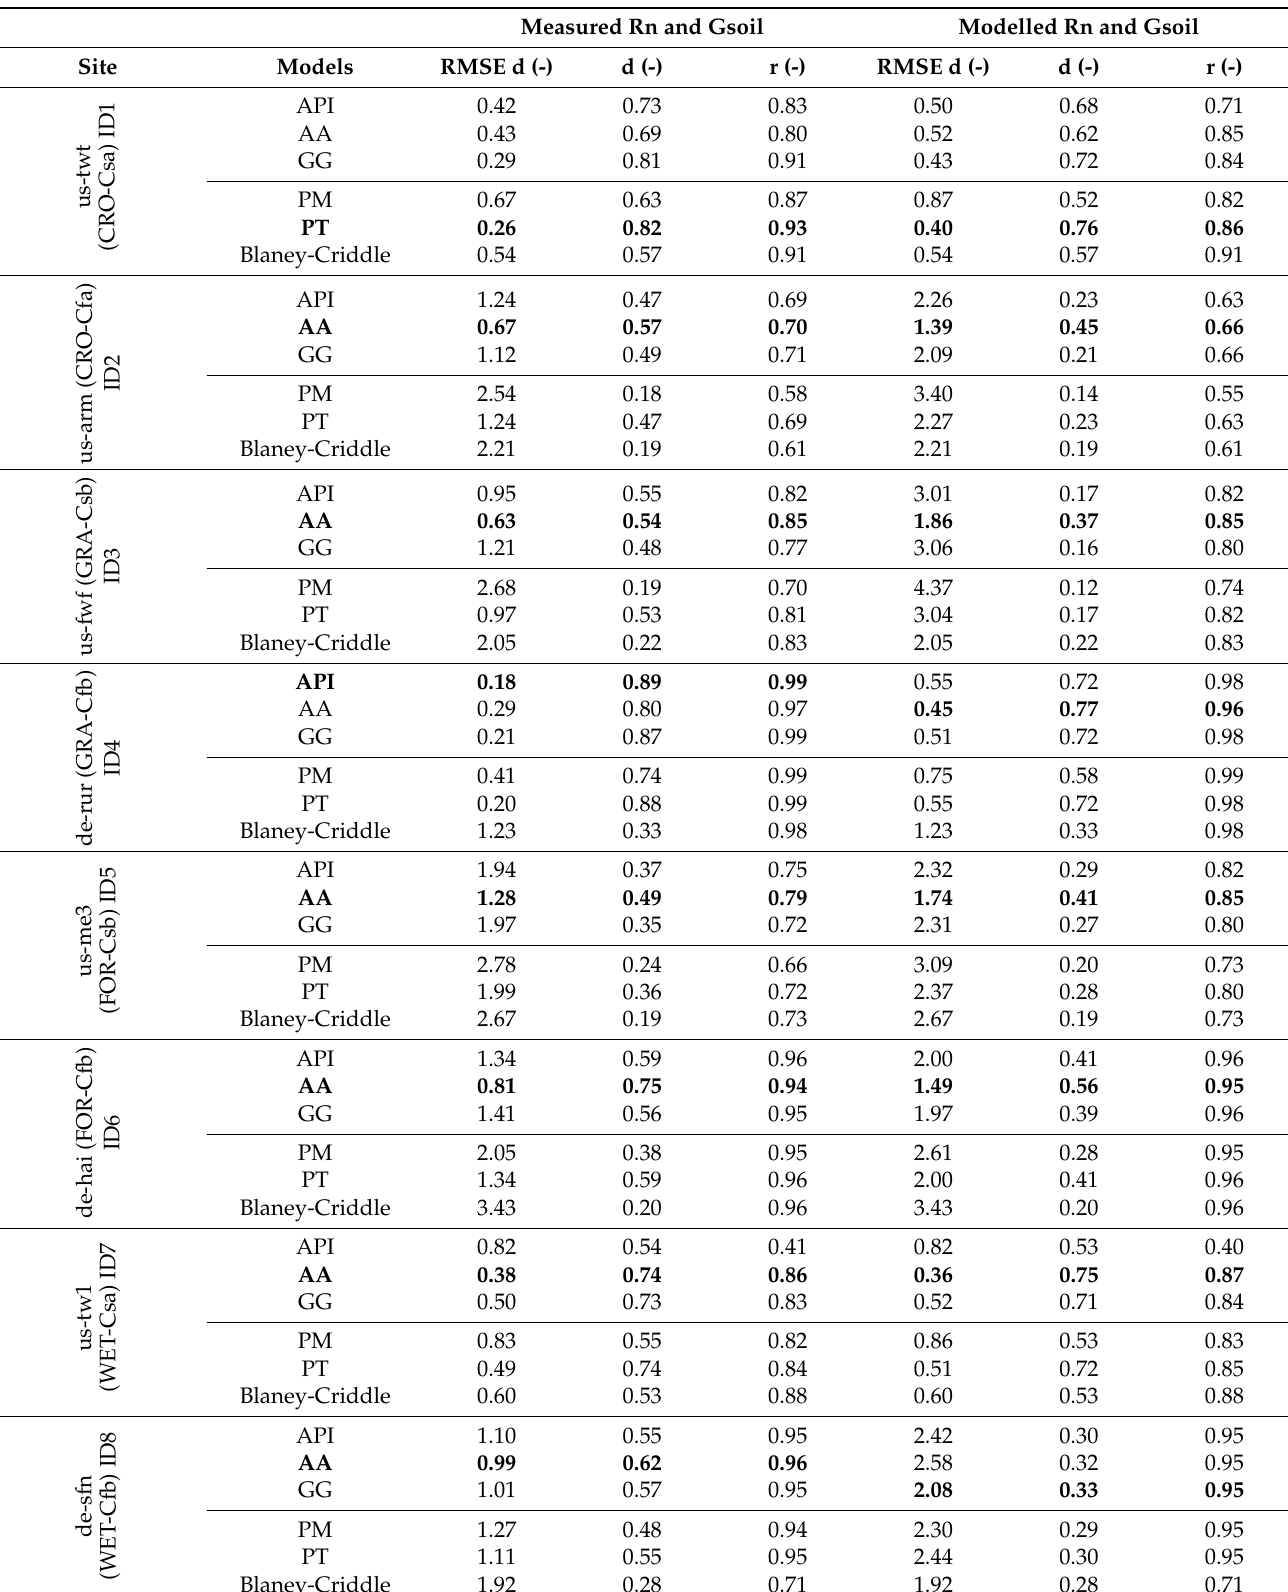
Table 5. Goodness of fit indices computed for each approach and site. In bold the most accurate model for each site. Measured Rn and